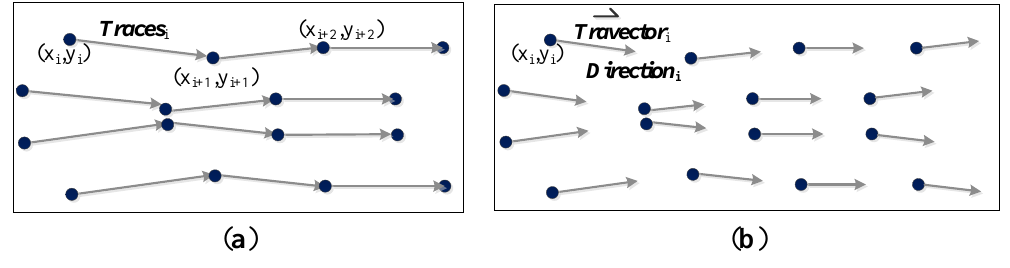
Figure 8. Trajectories and trajectory vector description. ( a ) shows the trajectory vector constructed according to traditional style; ( b ) is the trajectory vector proposed in this